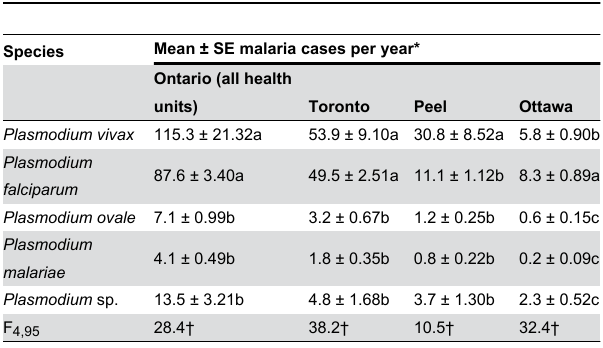
Table 2. Gender of imported malaria cases by jurisdiction and Plasmodium agent in Ontario, Canada